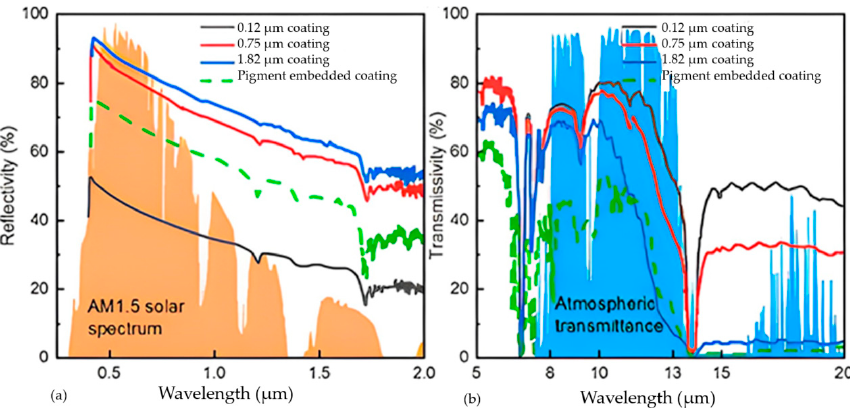
Figure 36. ( a ) Solar spectrum reflectivity and ( b ) the IR transmissivity spectrum of TiO 2 coating films of various thicknesses [42,172].